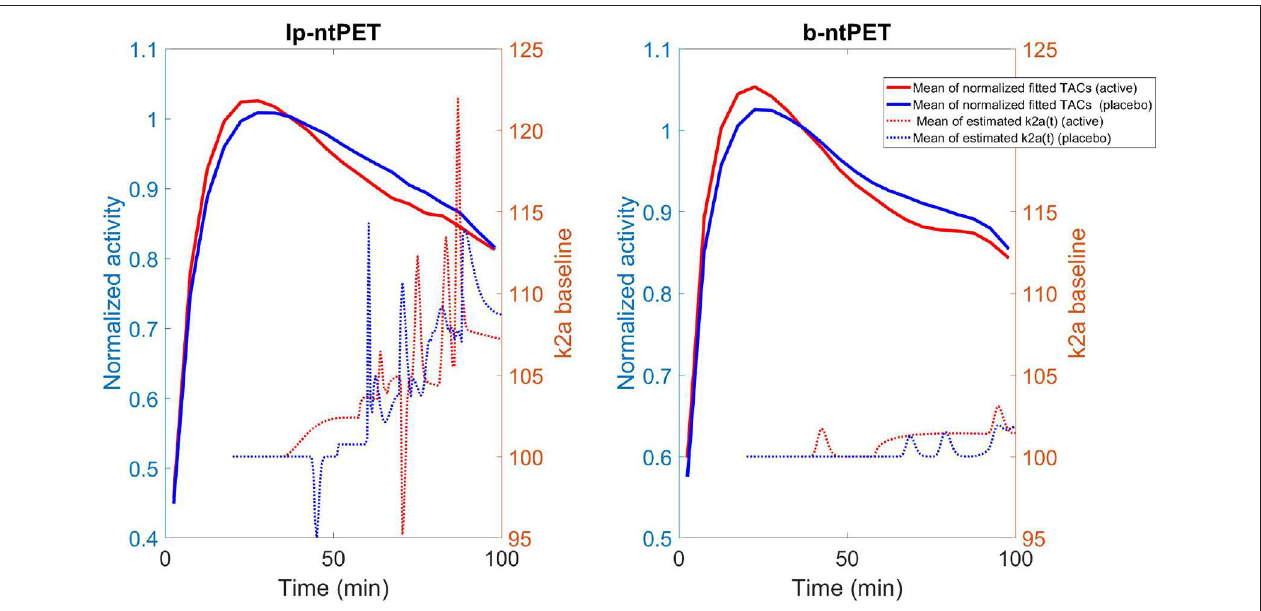
FIGURE 14 | For both methods, solid line: the mean of the endogenous releases estimated for the active (red) and placebo (blues) groups using both methods; dashed line: the mean of the associated k % baseline 2 a ( t )